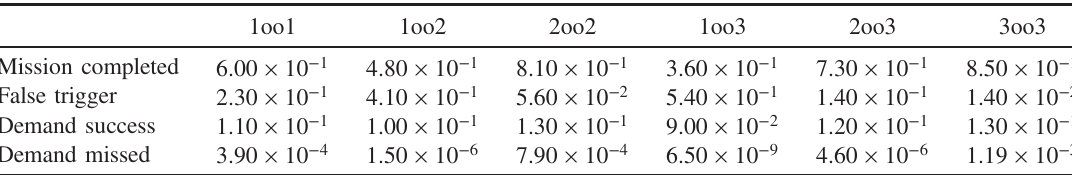
TABLE V. Case I: Scenario probabilities for the different architectures. Default input parameters,